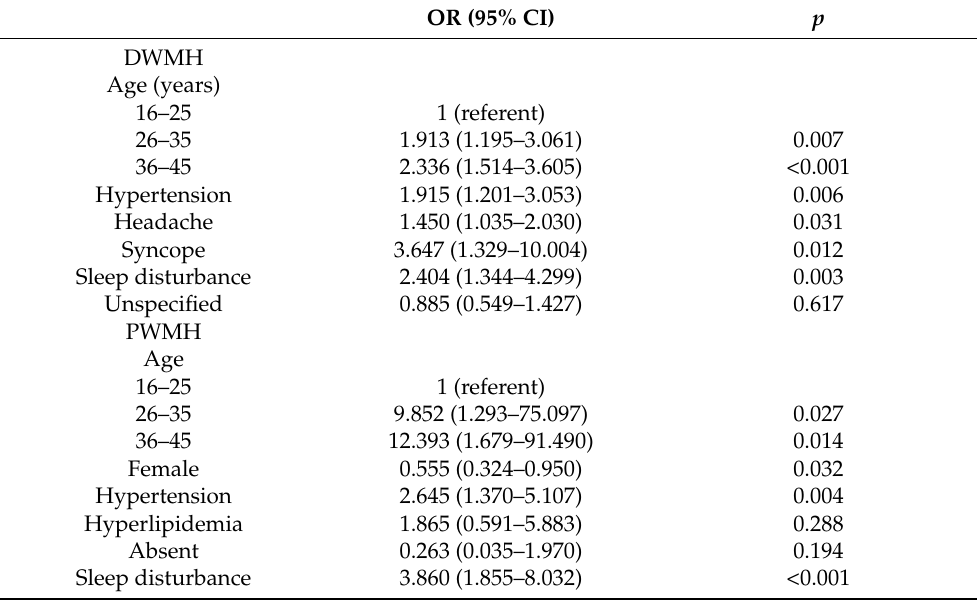
Table 4. Logistic regression analysis for the risk factors and WMH.